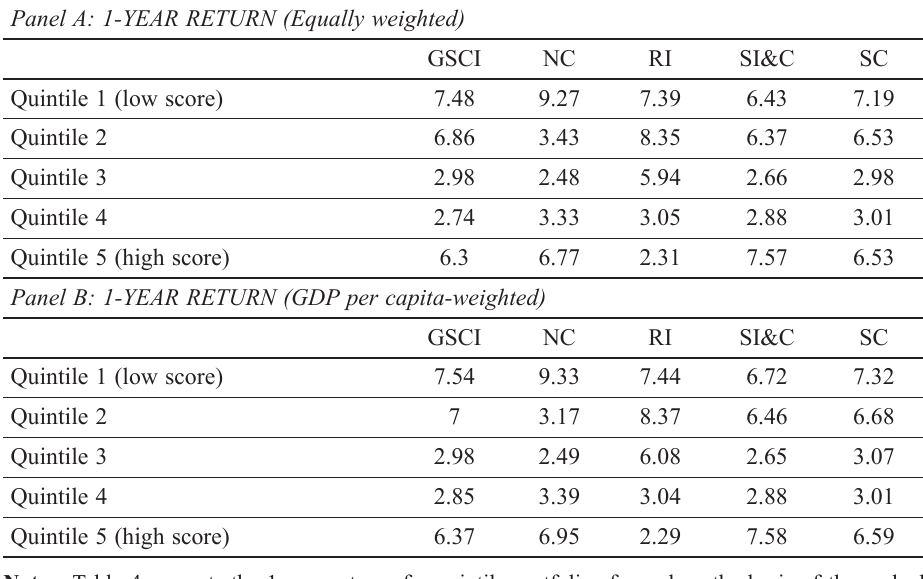
Table 4. 1-year returns for portfolios based on quintiles of sustainability scores (%) Panel A: 1-YEAR RETURN (Equally